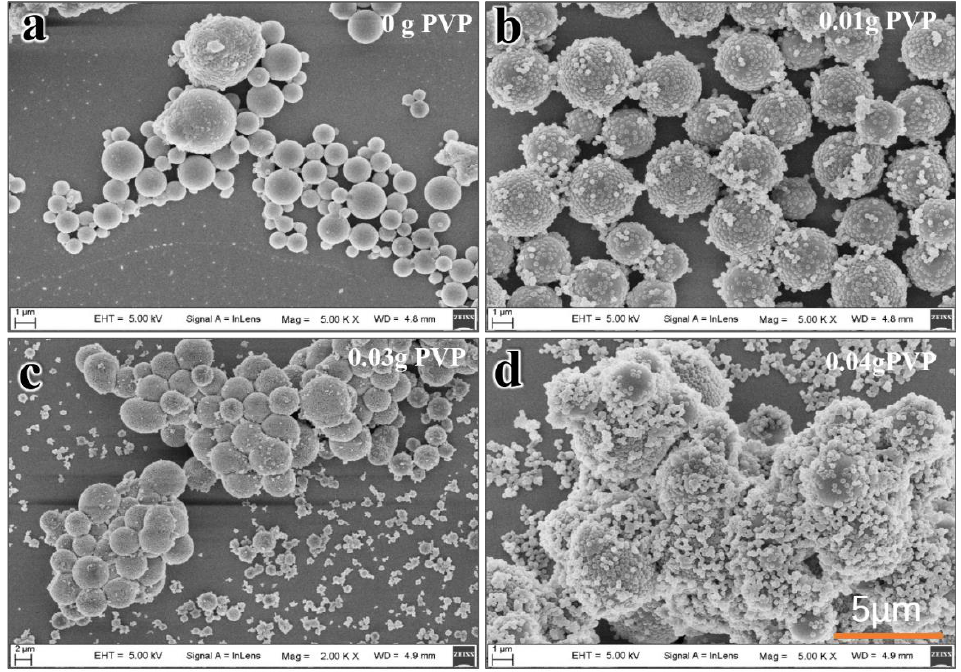
Figure 7. E ff ects of polyvinylpyrrolidone (PVP) contents on the SEM images of HSOS particles; ( a ) 0 g, ( b ) 0.01 g, ( c ) 0.03 g, ( d ) 0.04 g.